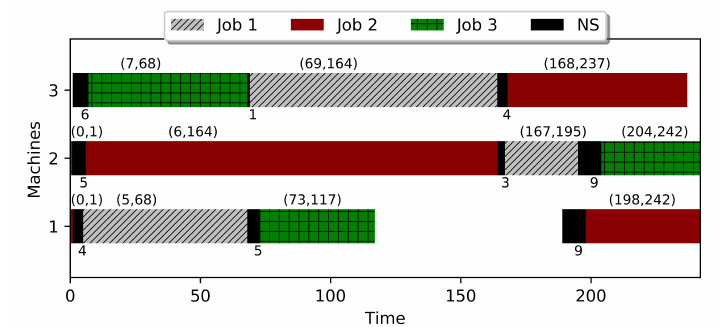
Figure 8. The detailed Gantt chart of the optimal solution found for the instance problem; blocking CJSS problem with sequence-dependent nonanticipatory setups